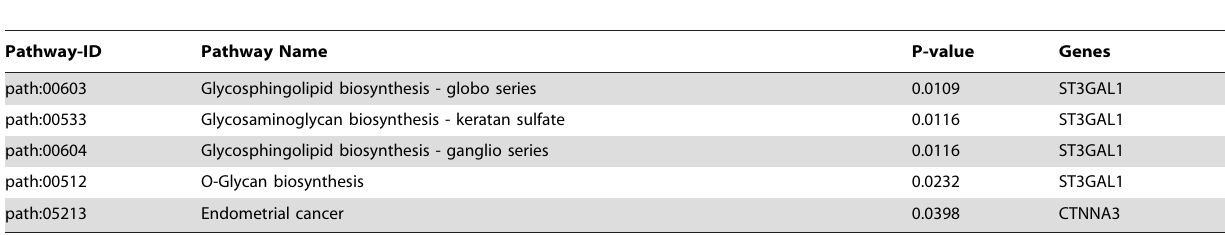
Table 3. Results of Gene Ontology Analysis for Negative Symptoms of SCZ Associated SNPs with P Meta-analysis , 3.04 6 10 2 5 , Gene Ontology Categories with Enrichment P-values ,